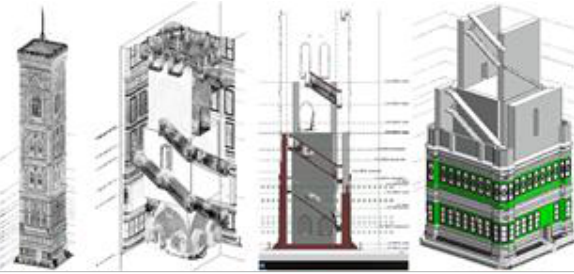
Figure 9 . An example of BIM model as authored during the training at the Master in Pisa: portion of the belfry by Giotto in Florence (model authored from a point cloud through ScanToBim techniques by Roberto Di Rienzo, who attended the Master course in